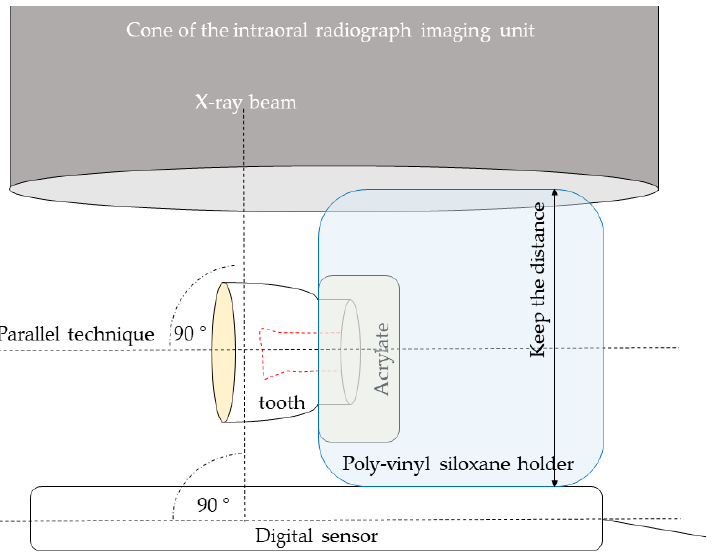
Figure 7. Schematic of the experimental set-up for radiograph taking during dentin thickness reduction.